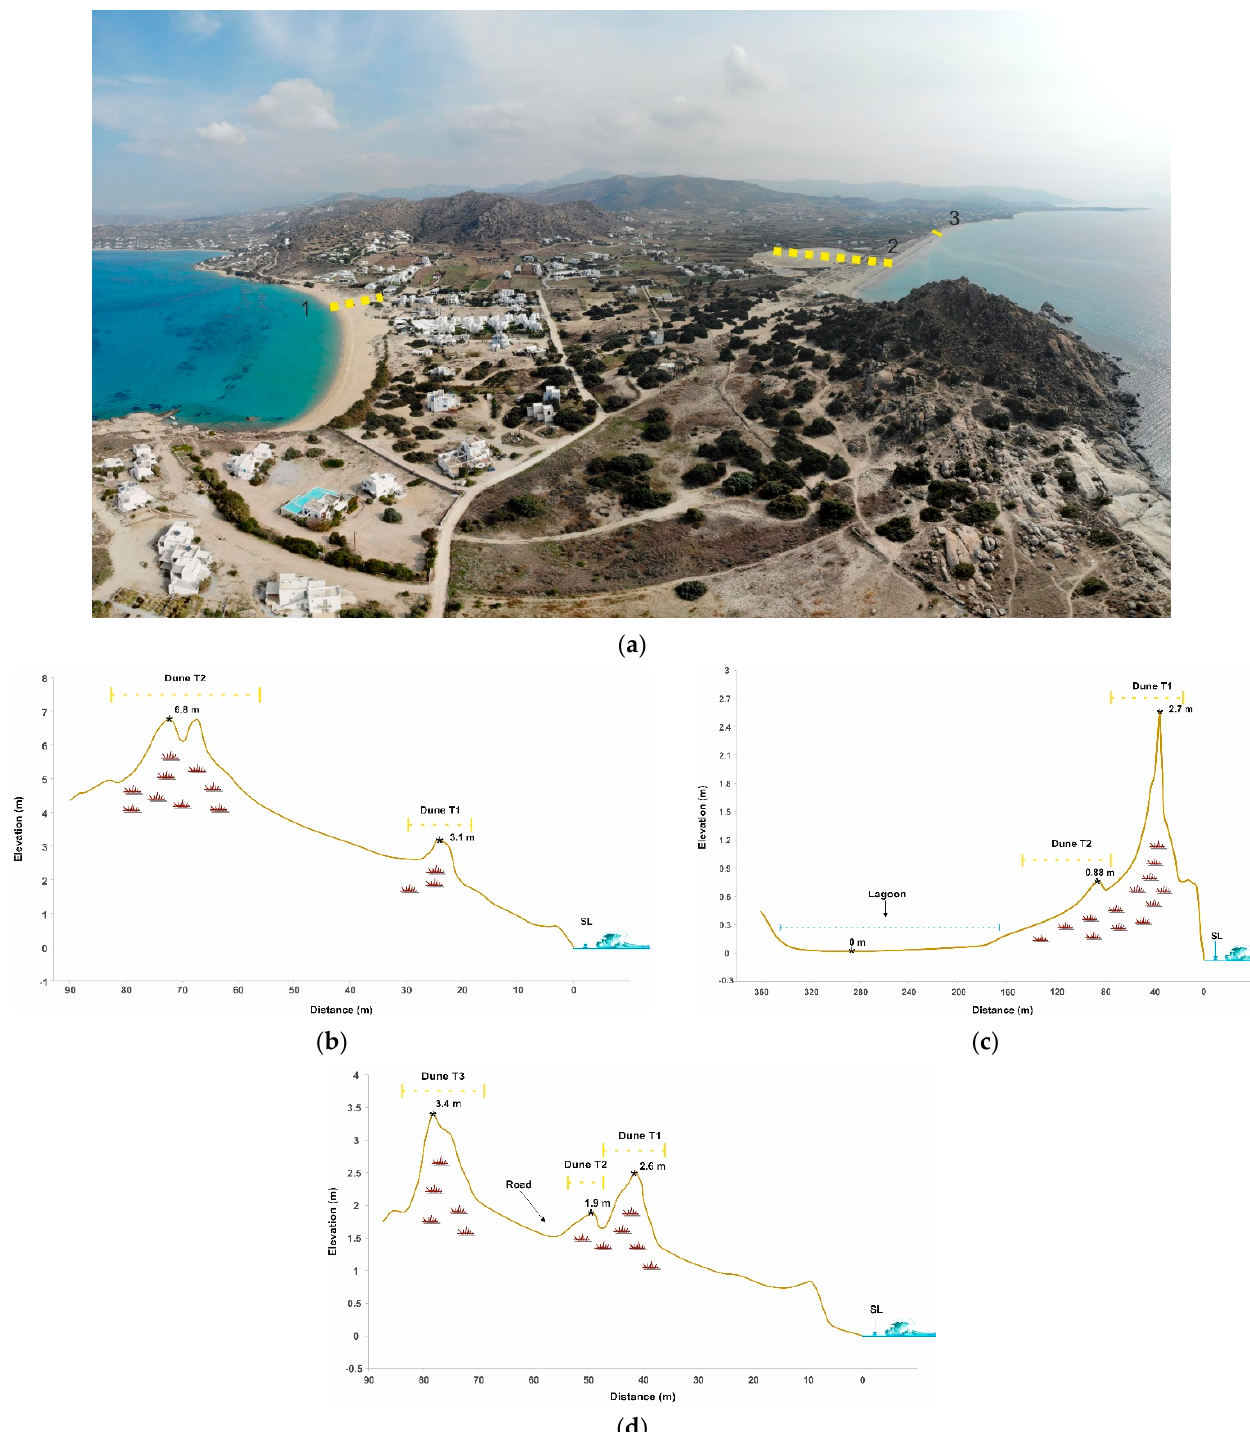
Figure 7. ( a ) Aerial photograph of Mikri Vigla site, with the locations of the three sections; Sketch of cross section Mikri Vigla 1 ( b ); ( c ) Mikri Vigla 2 and ( d ) Mikri Vigla 3 .